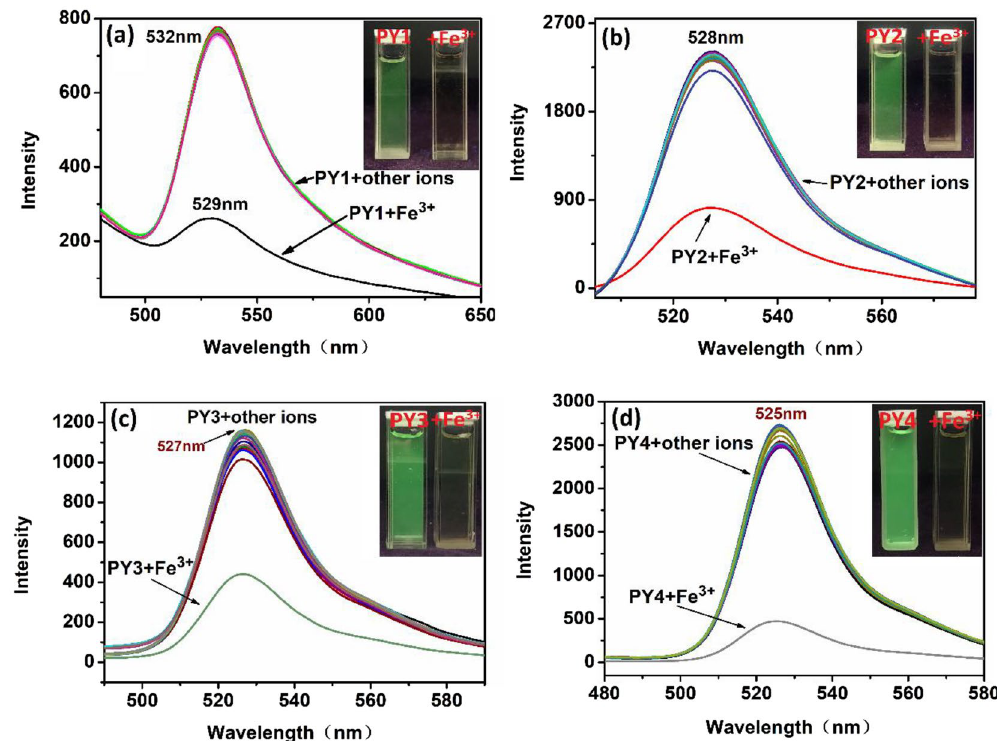
Fig. 4 Fluorescence spectra of a PY1 (1 µM, λ nm) in the presence of 10 equivalents of metal ions (10 µM) in DMF buffer (pH = 7.0,